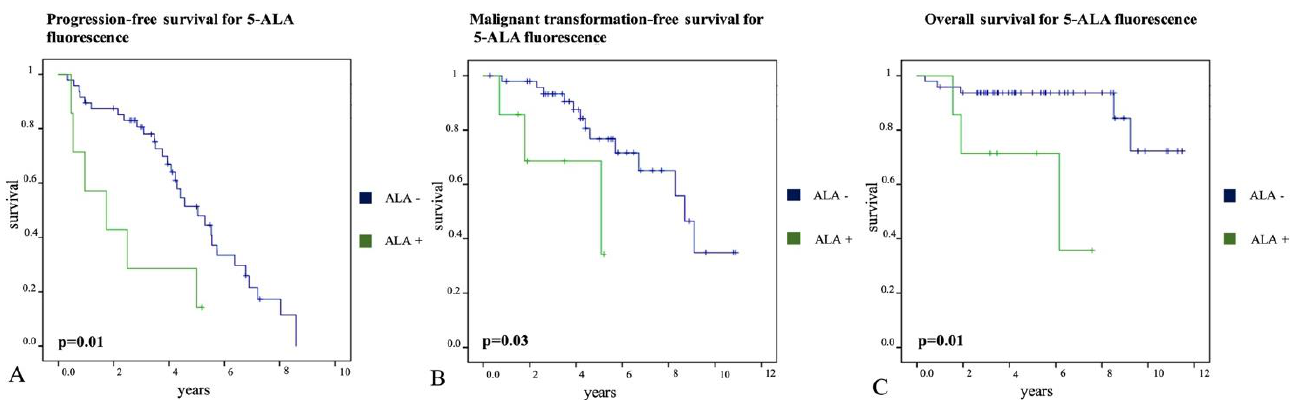
Figure 3. Visible 5-ALA fluorescence and patient prognosis in patients with low-grade gliomas. Kaplan–Meier curves demonstrate survival of patients showing visible intraoperative fluorescence (5-ALA +) compared to patients without any intratumoral fluorescence (5-ALA −). Tumor progression was defined as development of new lesions or increase of contrast-enhancement and/or increase of T2 or FLAIR lesion >25% on MRI or tumor-related death. Malignant transformation was defined as progression to anaplastic glioma (WHO III) or glioblastoma (WHO IV) at reoperation. Overall survival was calculated as time from initial surgery to patient’s death. A significantly shorter progression-free survival (2.3 ± 0.7 vs. 5.0 ± 0.4 years; p = 0.01; ( A )), malignant transformation-free survival (3.9 ± 0.7 vs. 8.0 ± 0.6 years; p = 0.03; ( B )), and overall survival (5.4 ± 1.0 vs. 10.3 ± 0.5 years; p = 0.01; ( C )) was observed in patients with fluorescing LGG during surgery as compared to non-fluorescing tumors.